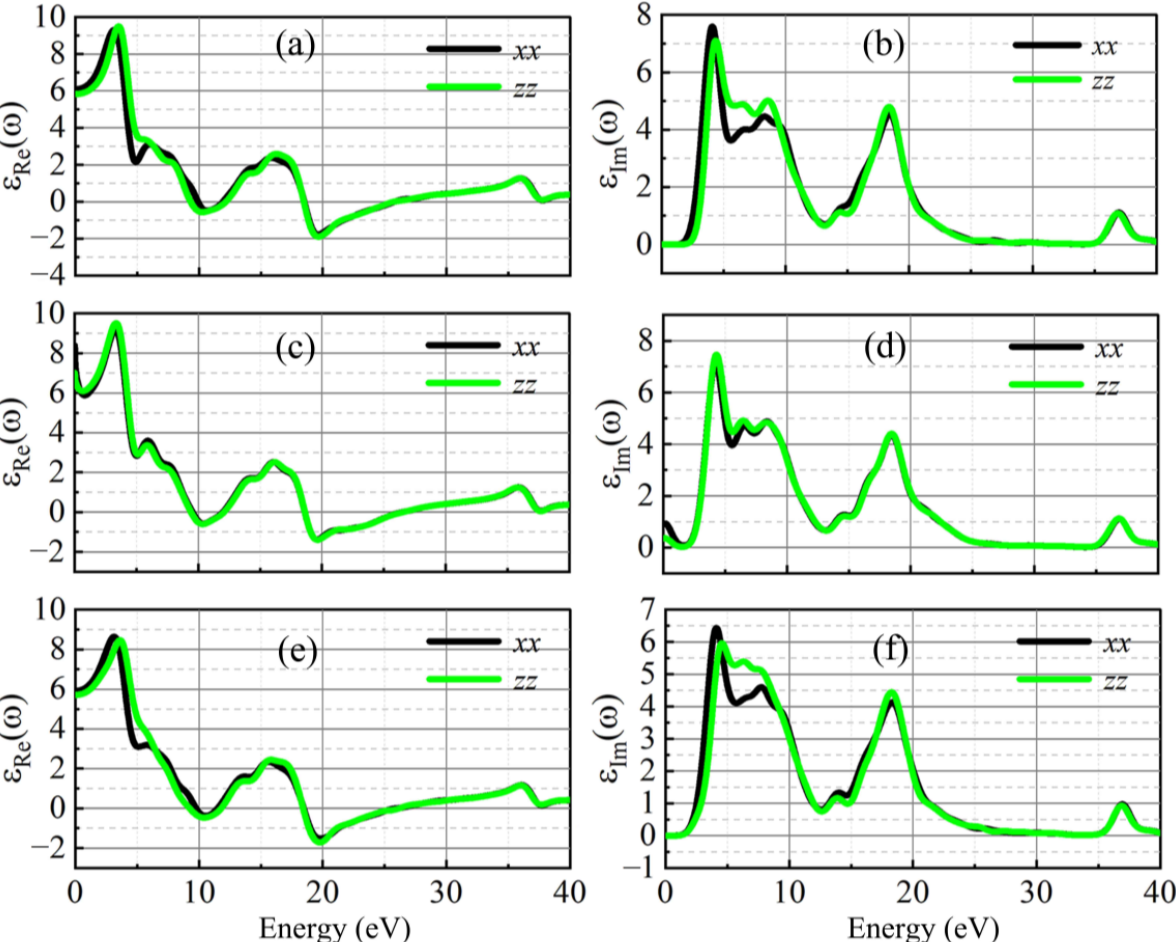
Figure 5. The real and imaginary parts of the dielectric function: ( a , b ) pure BaTiO 3 , ( c , d ) Ba 0.875 TiCe 0.125 O 3 , and ( e , f ) BaTi 0.875 Ce 0.125 O 3